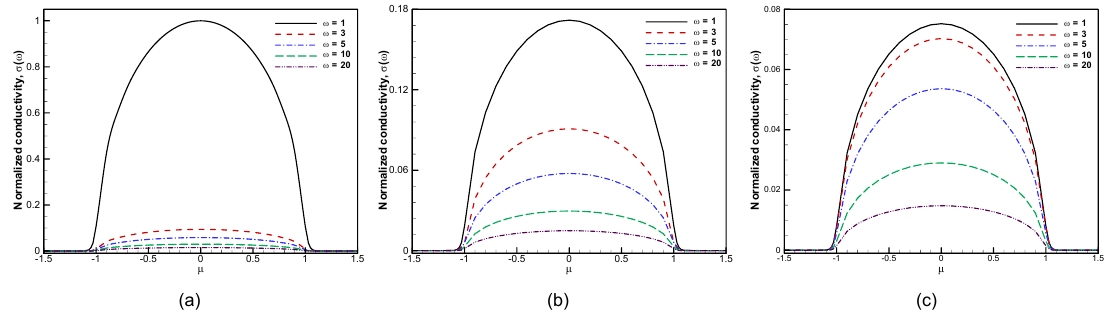
Figure 7. Computed electrical conductivity vs. chemical potential for various electric frequency ω = 1,3,5,10,20 at ( a ) E 0 = 10 3 V/cm, ( b ) E 0 = 10 4 V/cm, and ( c ) E 0 = 2.5 × 10 4 V/cm with β = 50 and τ = 1.0.